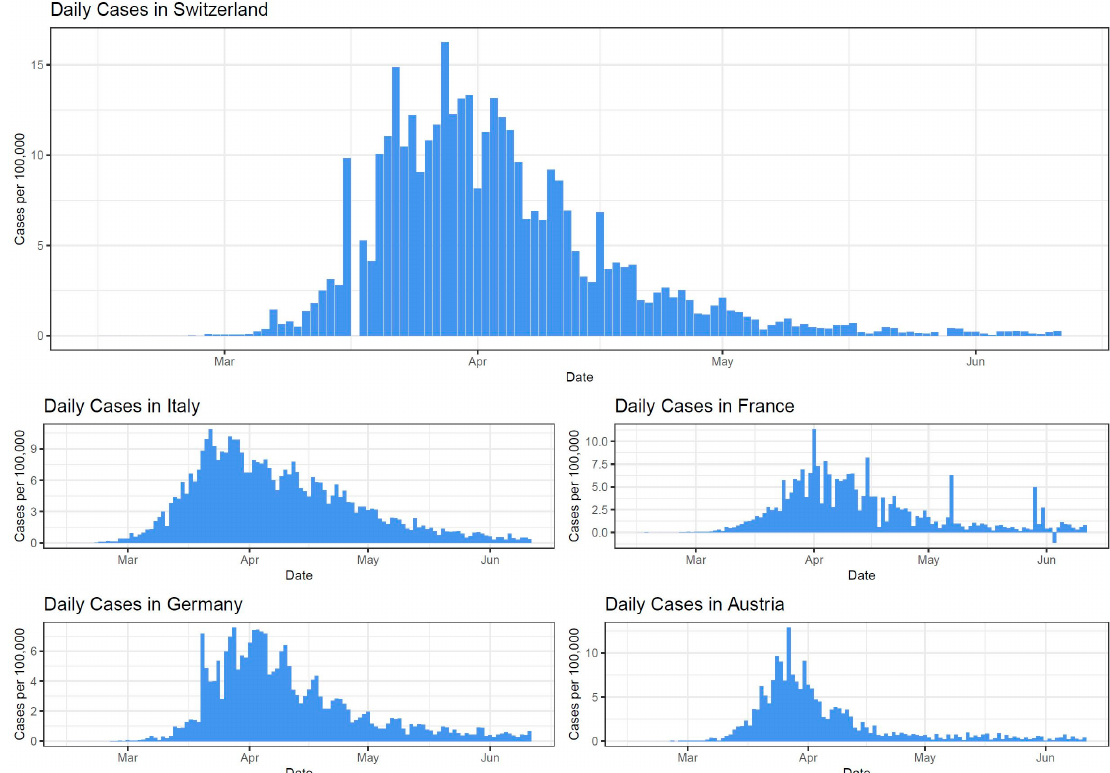
Figure 1. The epidemiological curves of Switzerland, Italy, France, Germany, and Austria’s daily numbers of new reported cases of COVID-19 per 100,000. The epi-curve starts on 15 January 2020, and ends on 11 June 2020. Based on the data from the European CDC.